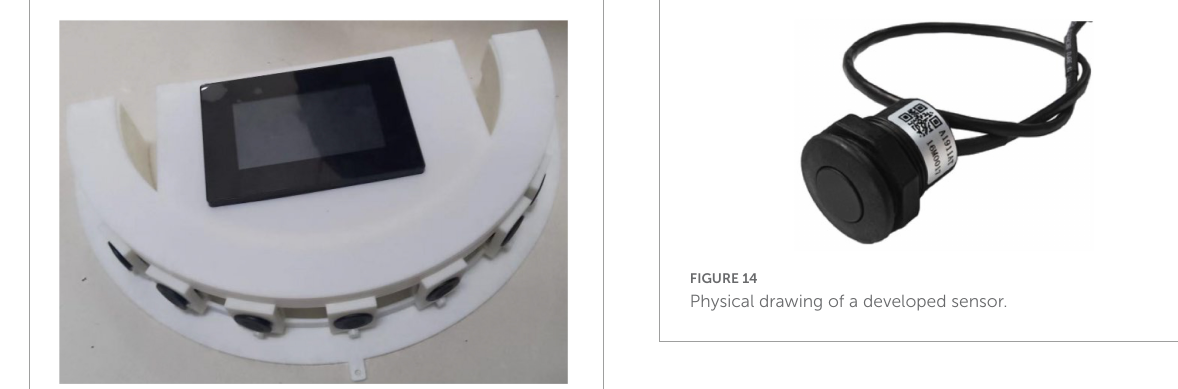
FIGURE13 Physical drawing of a developed sensor.